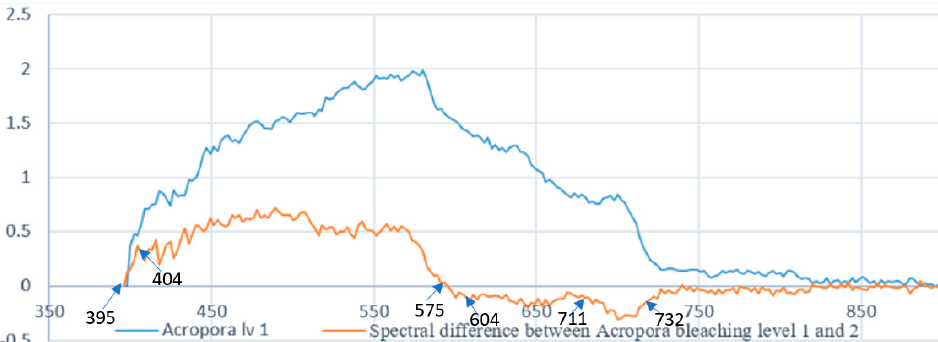
Figure 11. Spectral signature comparison for reef index generation Alv1.